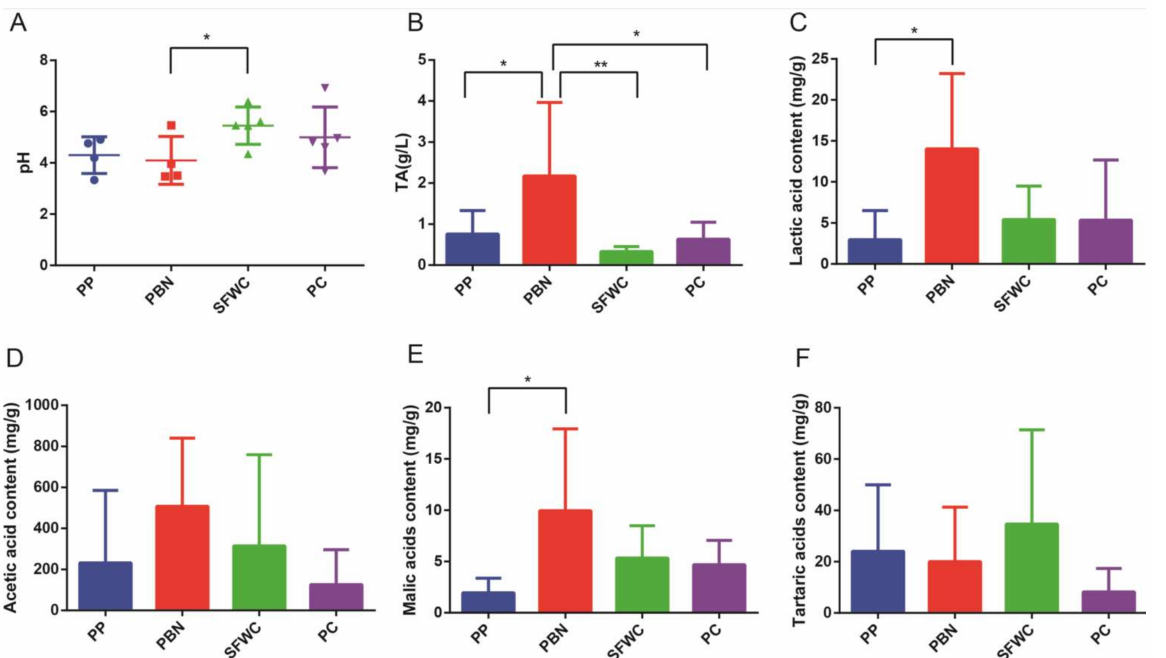
Figure 1. Comparison of physicochemical characteristics in four traditional fermented vegetables.